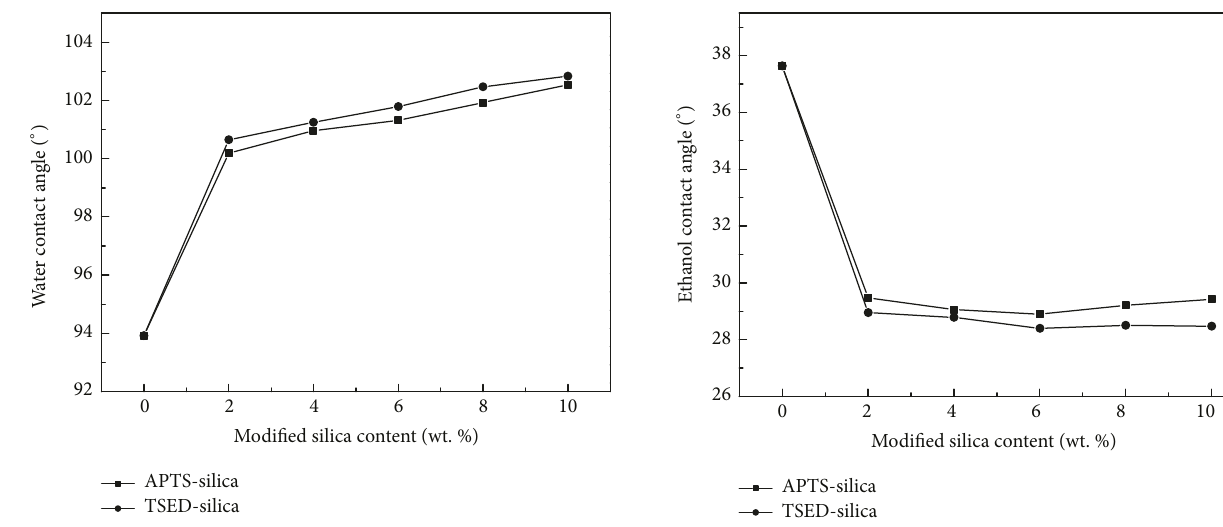
Figure 6: Contact angle of ethanol at the surface of modified PDMS